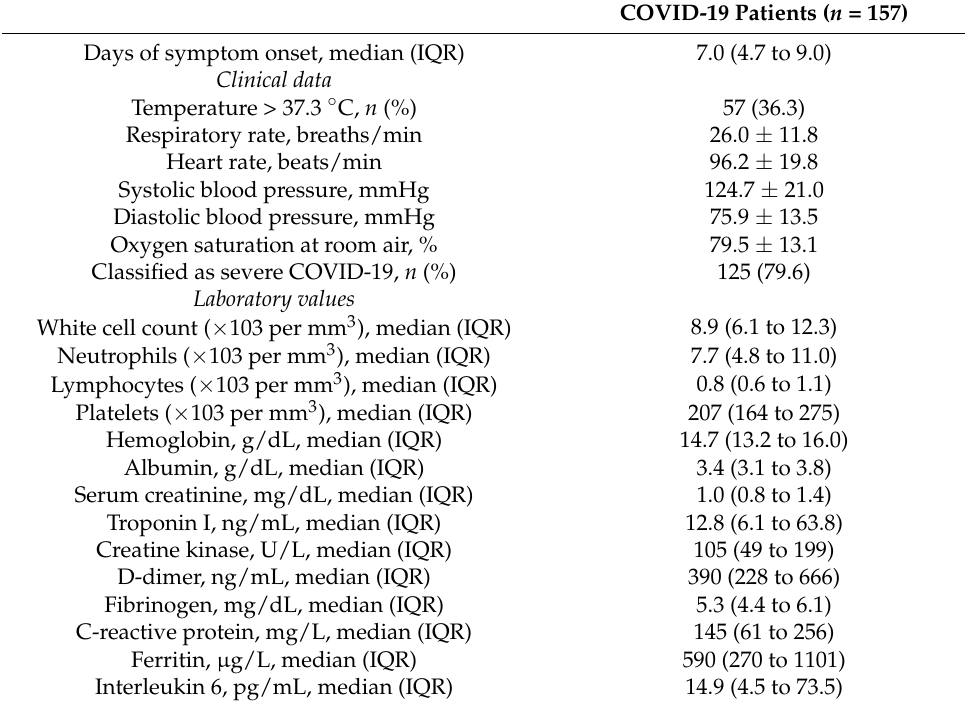
Table 2. Main findings at hospital admission of study